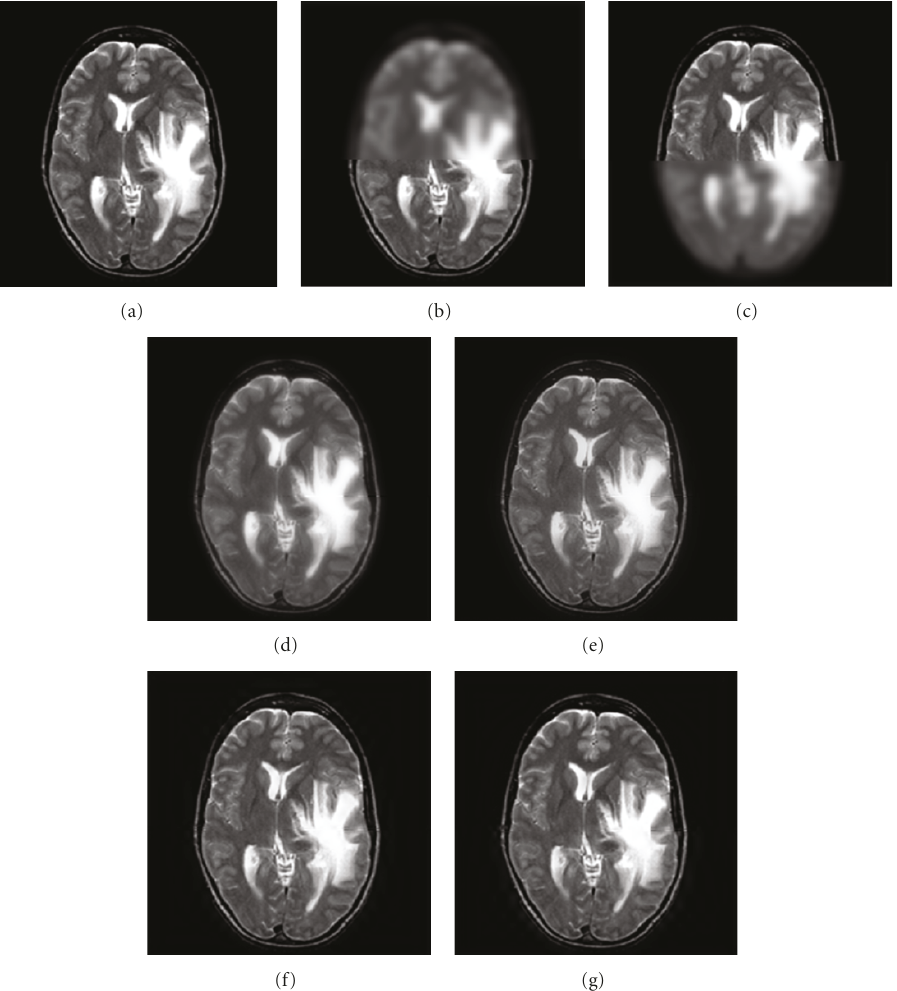
Figure 5: Medical image fusion with the simulated pair from a T2-weighted MR image. (a) The original medical image (reference image or ground truth); (b) image blurred on the top; (c) image blurred on the bottom; (d) fused image by pixel averaging; (e) fused image by gradient pyramid; (f) fused image by DWT; (g) fused image by the proposed method.